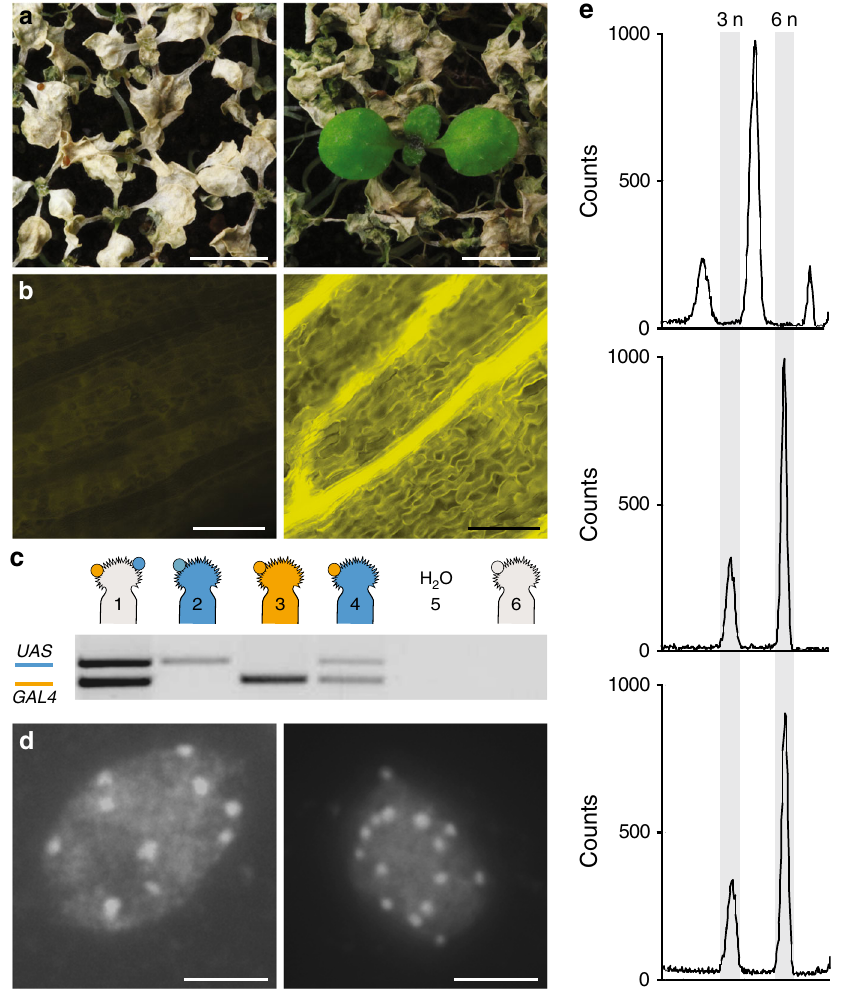
Fig. 2 HIPOD identi fi es plants with three parents. a Herbicide-treated offspring of diploid wild type (left) and plants recovered from HIPOD (right). b YFP fl uorescence analysis of diploid wild type (left) and plants recovered from HIPOD (right). c Multiplex PCR targeting pUAS::BAR-YFP (blue) and pRPS5a:: mGAL4-VP16 (orange) in (1) herbicide-resistant plant recovered from HIPOD, (2) pUAS::BAR-YFP/ + , (3) pRPS5a::mGAL4-VP16/ + , (4) pUAS::BAR-YFP/ − , pRPS5a::mGAL4-VP16/ − , (5) water control, (6) wild-type control. The crossing scheme resulting in the F1 plants analyzed is indicated in the cartoon. d DAPI stained chromosome spreads of a diploid wild-type plant (left) and a plant recovered from HIPOD (right). e Flow cytometric analysis of diploid wild- type plant (upper panel), triploid wild-type plant (middle panel) and a herbicide-resistant plant recovered from HIPOD (lower panel). Scale bars, 0.4 cm a , 100 µ m b , and 5 µ m